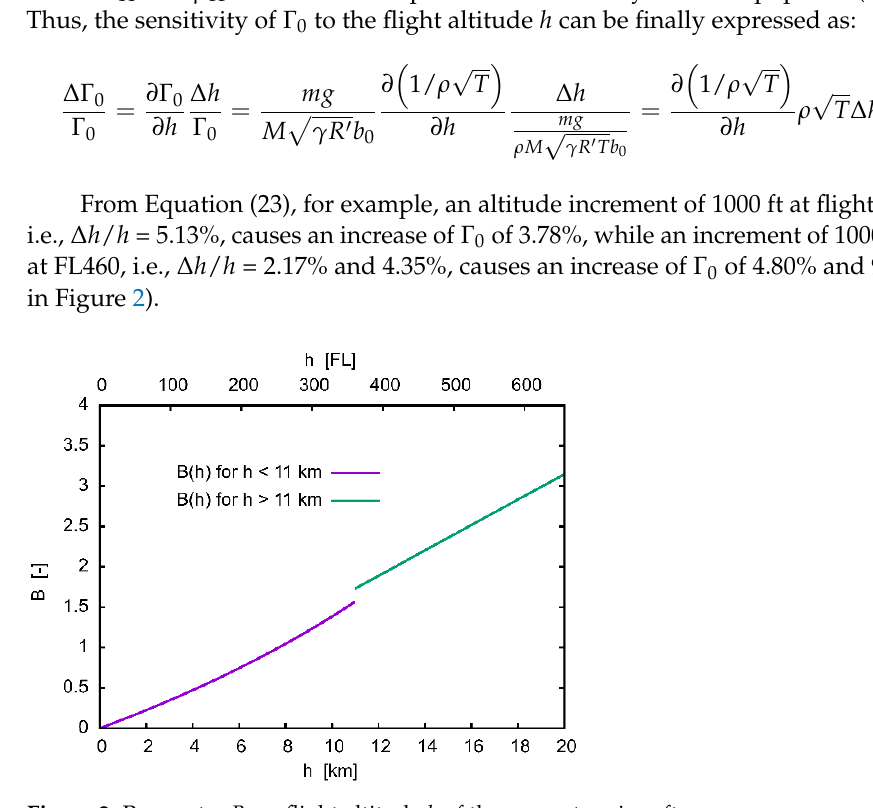
Figure 2. Parameter 𝐵 vs. flight altitude ℎ of the generator aircraft.